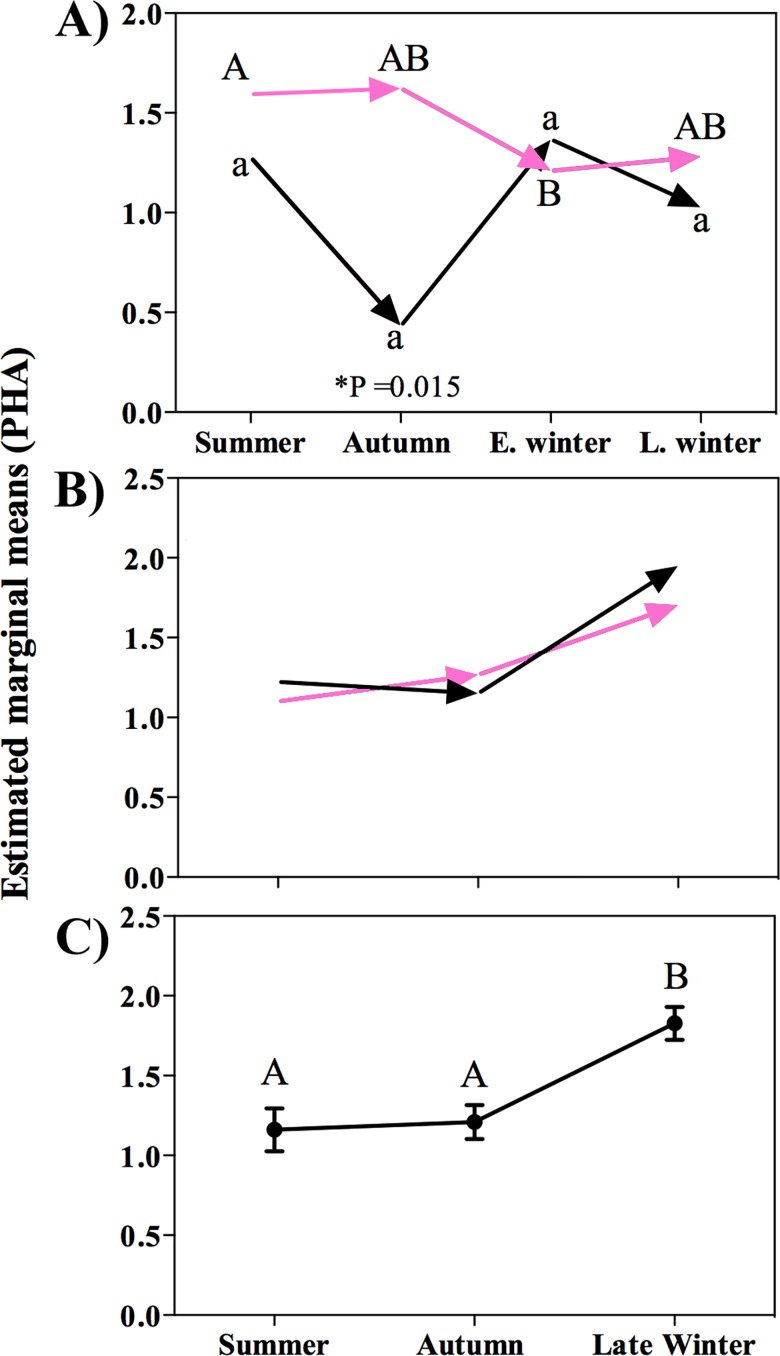
Seasonal swelling response after 6 hours of PHA post injection.A) P1, pink arrows represent seasonal variation in the swelling response in females; black arrows represent seasonal changes in the swelling response in males; different letters indicate significant differences among seasons within a period; asterisks indicate differences between periods for a given season. B) P2, pink arrows represent females and black arrows represent males; no significant differences were found. C) Combined data from P2 (estimated mean ± SE).